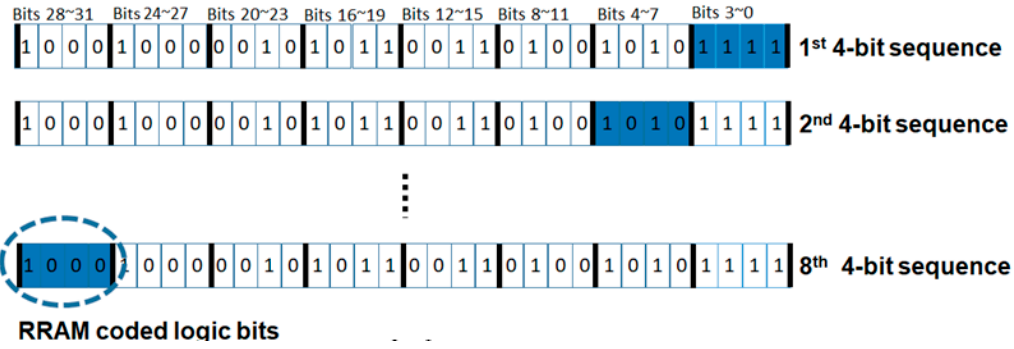
Figure 9. The blue-shaded 4-bit string represents the bits where RRAM resistance values are encoded and the remaining 28 bits represent the unchanged binary version of the algorithm trained weight.